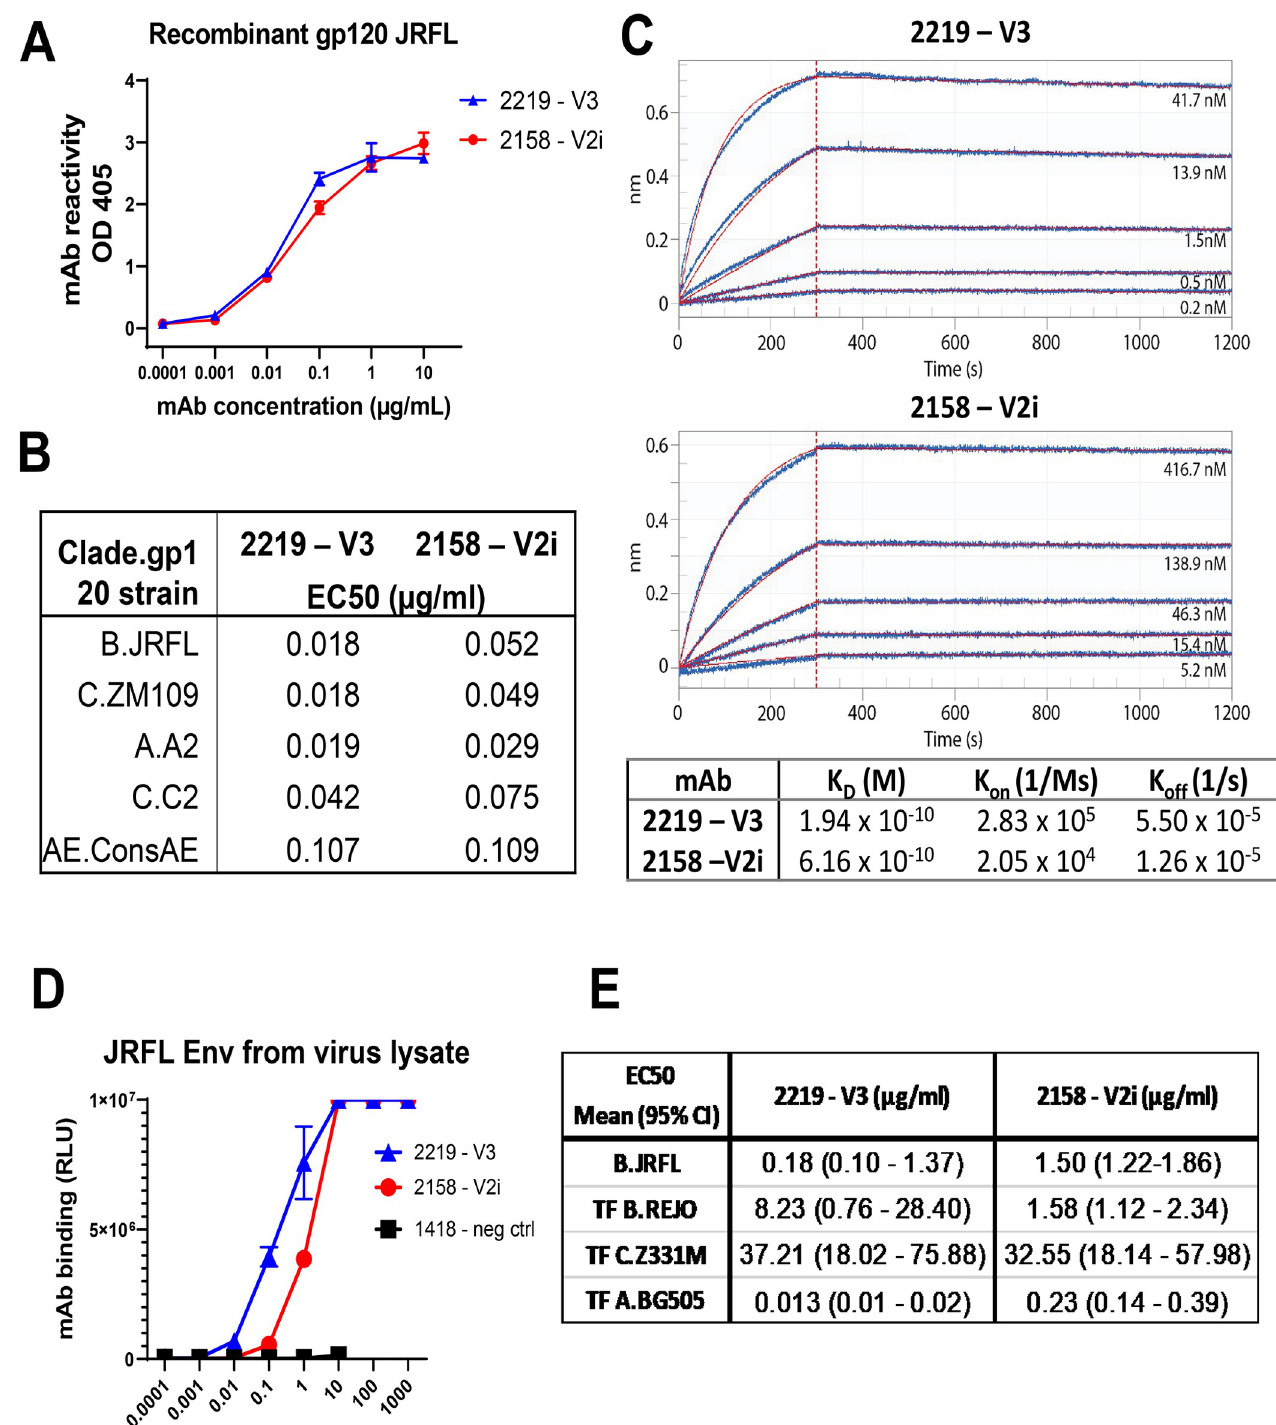
Fig 2. The binding strength of V2i vs V3 mAb to recombinant JRFL gp120 or virus-derived gp120. A) Direct ELISA measurement of mAb reactivity to recombinant JRFL gp120 (1 μ g/ml coated on plates). B) EC50 values of mAb ELISA binding to recombinant gp120 proteins from different HIV-1 strains. C) Kinetics analysis of mAbs binding to recombinant JRFL gp120 by biolayer interferometry. mAbs were captured by anti-hIgG Fc biosensors and reacted with monomeric gp120 in solution for measurement of Fab-gp120 affinity. Fitted curves (1:1 binding model) are shown in red. Molar concentrations of gp120 are